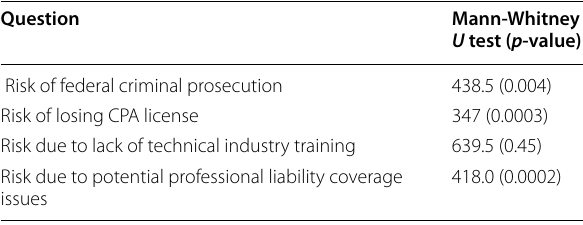
states. Table 6 summarizes the test statistics and p values for each risk area.